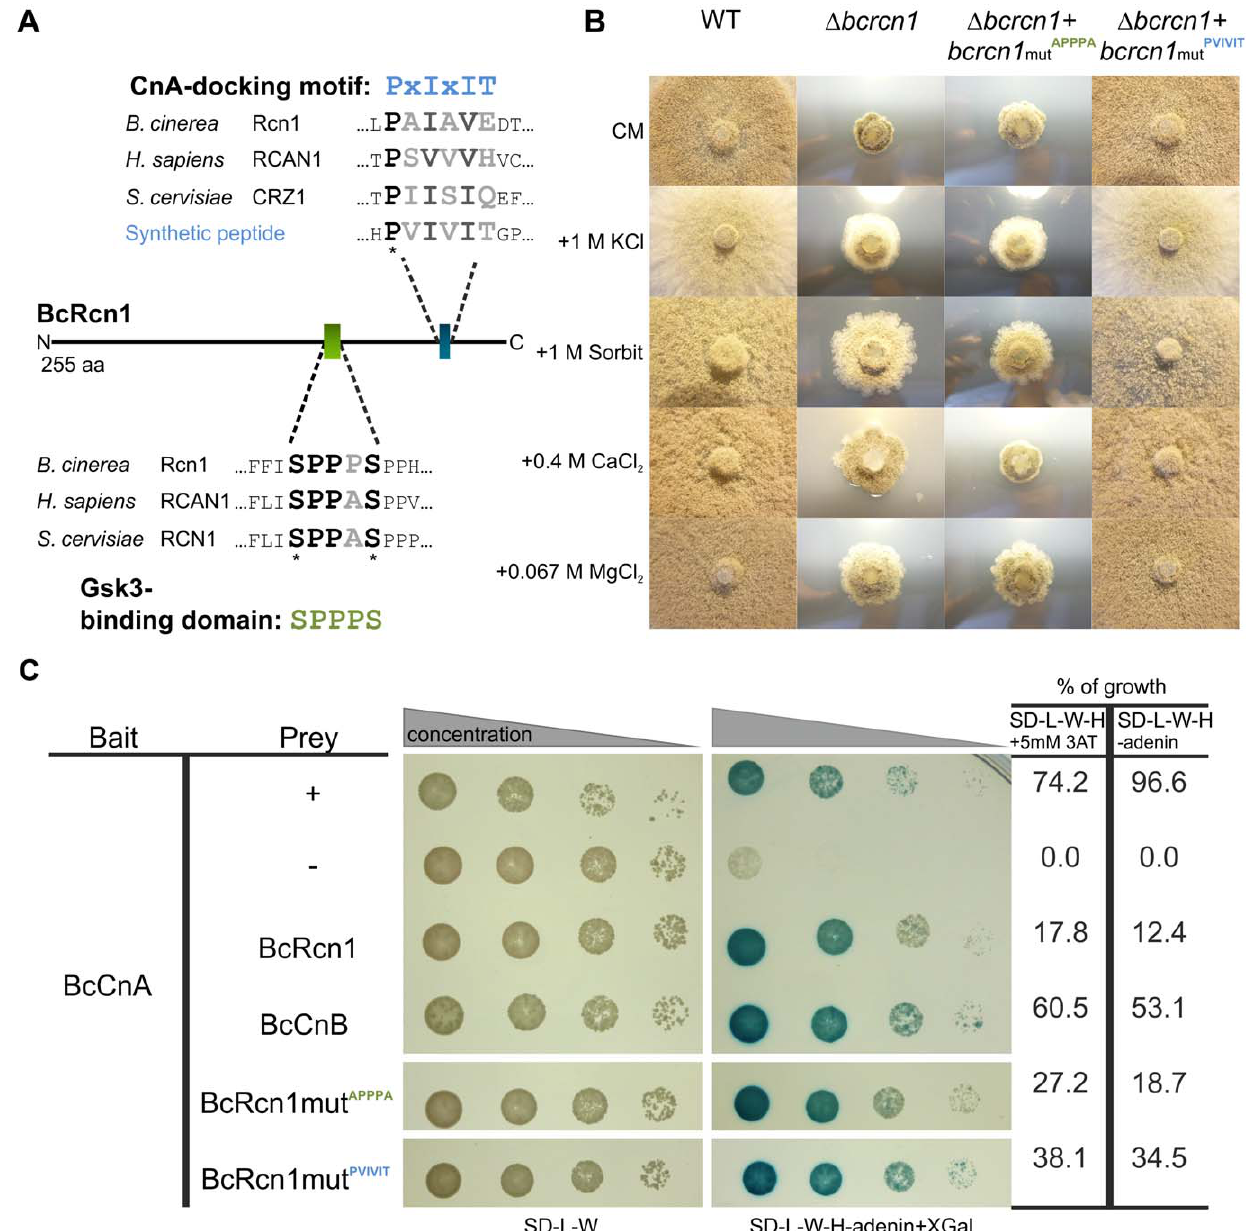
Figure 6. Characterization of calcipressin and calcineurin A interaction in B.cinerea . A: Alignments of the predicted CnA-docking motif and the putative Gsk3-binding domain in the BcRcn1 background (BcRcn1 protein: 255 aa). Mammalian and yeast as well as the synthetic peptide sequences derive from [45]. Black letters/stars: highly conserved residues; dark grayish letters: amino acids with strongly similar properties; light gray letters: weakly similar properties. B: Phenotype of mutated strains: growth analyses with wild-type B05.10 (WT), D bcrcn1 , D bcrcn1 + bcrcn1 mut APPPA , D bcrcn1 + bcrcn1 mut PVIVIT after 1 week on described media. Inoculation was made with agar plugs of equal size (5 mm). C: Yeast strain NMY51 was transformed with the bait vector containing the bccnA gene and different prey vectors: + control: pAI-Alg5, - control: pPR3-N, BcRcn1/BcCnB/ BcRcn1mut APPPA /BcRcn1mut PVIVIT : pPR3-N_BcRcn1/_BcCnB/_BcRcn1mut APPPA /_BcRcn1mut PVIVIT . Strains were incubated in different concentrations (non-diluted, 1:10, 1:100, 1:1000-diluted) on SD-L-W (selection for vectors) and on SD-L-W-H-adenin + X-Gal-plates (interaction of tested proteins). Percentage of growth was calculated by counting of colonies in comparison to number of colonies on SD-L-W. The test was performed three times.